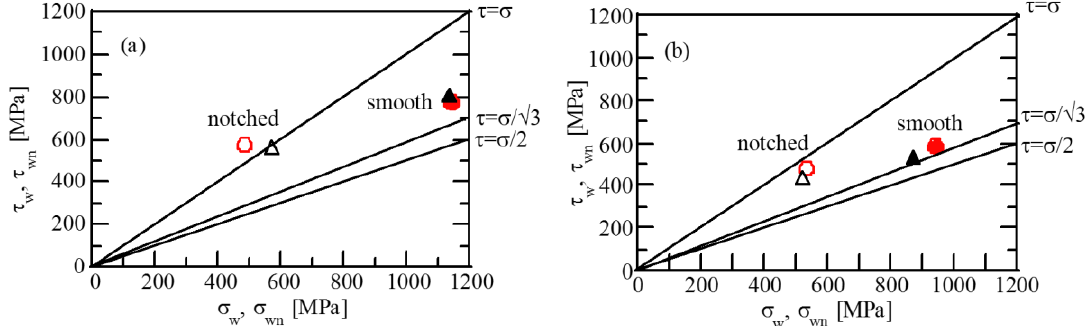
Figure 9. Relationships between torsional ( τ w , τ wn ) and rotational bending ( σ w , σ wn ) fatigue limits of TM (● ○ ) and SNCM420 ( ▲ △ ) steels subjected to ( a ) vacuum carburizing and subsequent fine particle peening and ( b ) heat-treating and subsequent fine particle peening. τ = σ , τ = σ √3 and = σ /2 are failure criterion of maximum principal stress, minimum shear strain energy, and maximum shear stress,